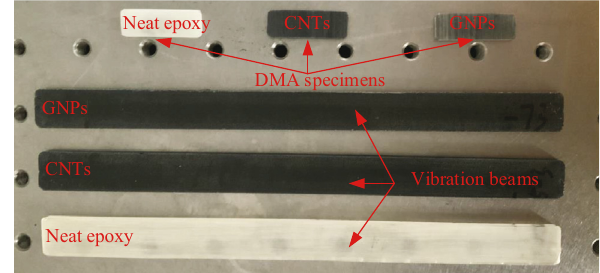
Figure 2: Specimens of epoxy composites reinforced